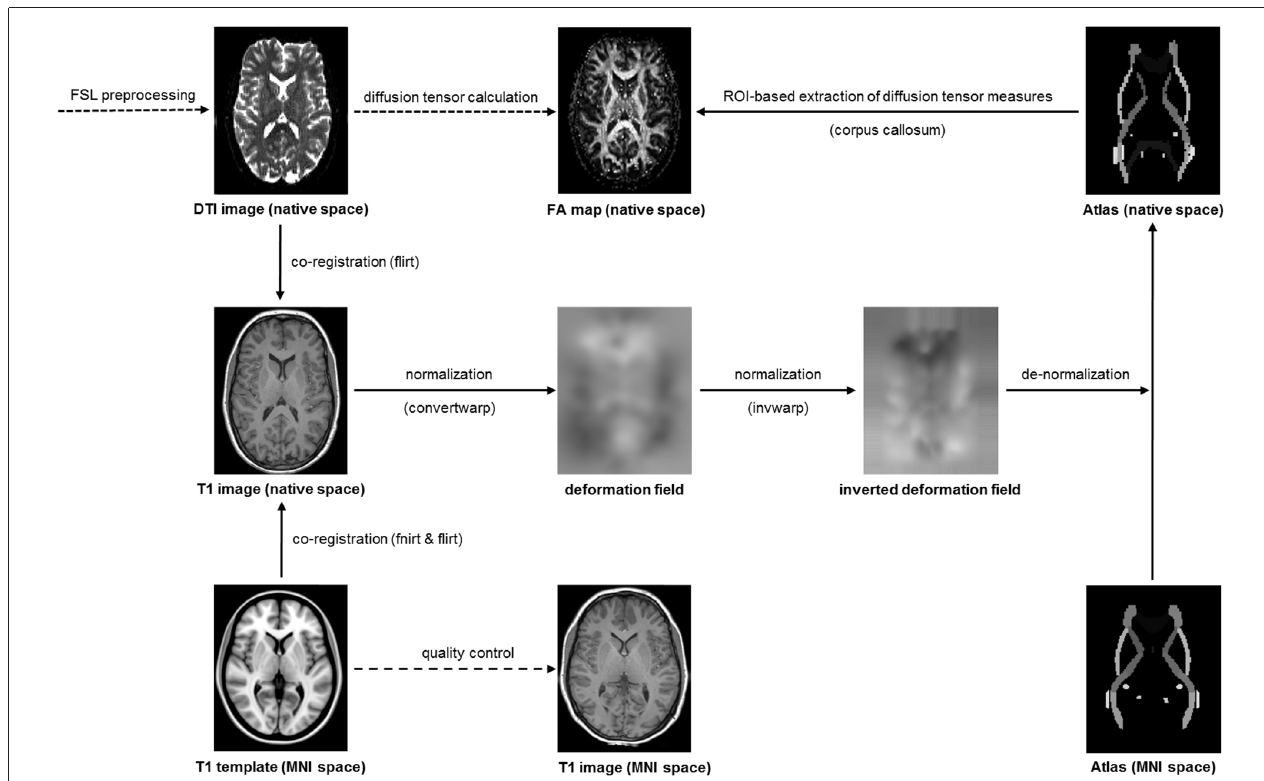
FIGURE 1 | Processing and analysis stream for the diffusion weighted images.